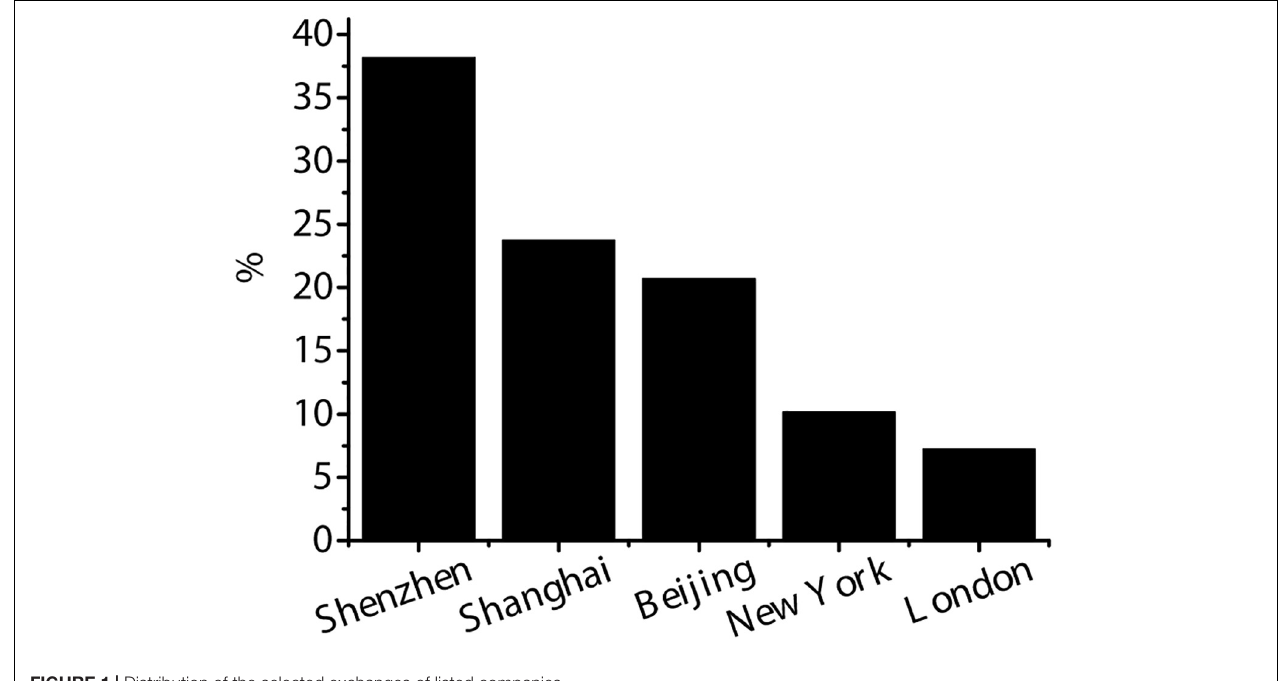
FIGURE 1 | Distribution of the selected exchanges of listed companies.